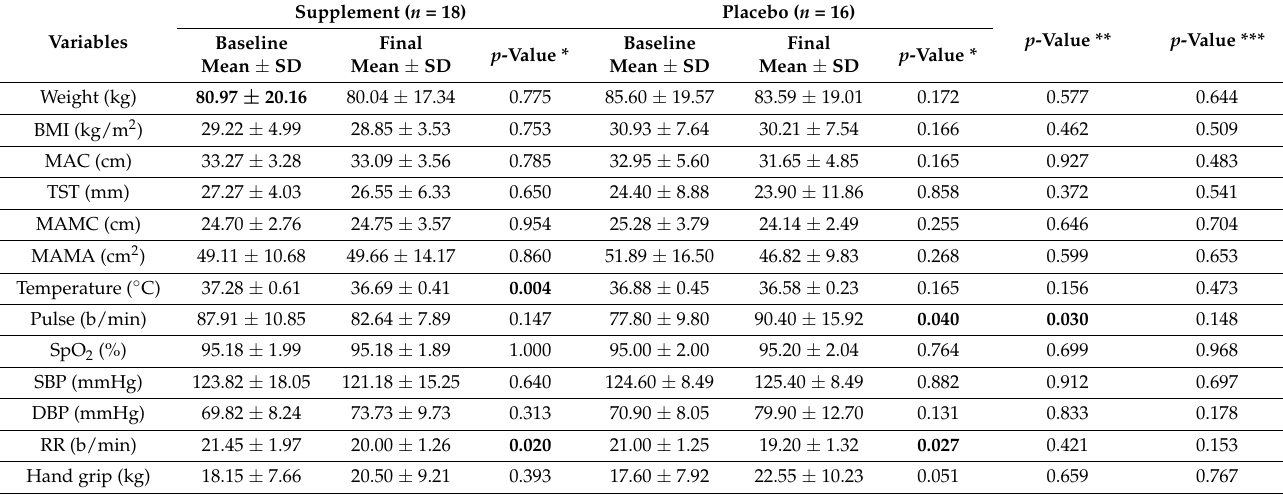
Table 2. Anthropometric and clinical parameters before and after intervention in both study groups.